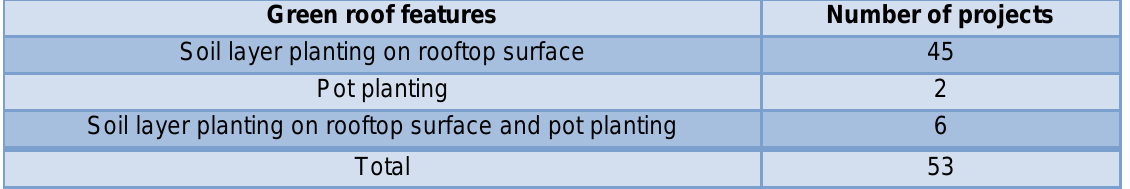
Table 4 A Breakdown of Direct Soil Planting on Rooftop Surface and/or Pot Planting from 2001 to 2006 (Legislative Council 2006) The main types of completed buildings with green roof features are schools and office buildings. Most of the green roof systems use soil layer planting on rooftop surface. However, there is no statistics for the total number of green roofs with extensive green roofs and intensive green roofs in Hong Kong buildings. Table 5 shows some examples of buildings which have applied green roofs in Hong Kong.